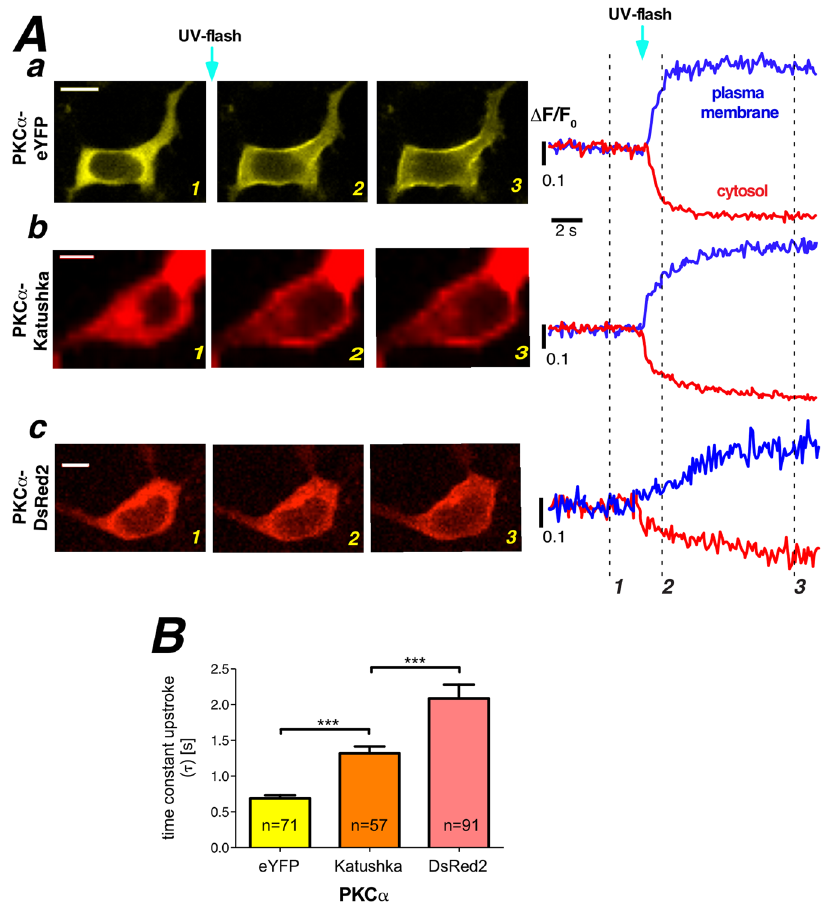
Figure 2. Properties of oligomerized PKC α -fluorescent protein. ( A ) Properties of PKC α translocation to the plasma membrane following UV flash photolysis for (Aa) PKC α -eYFP (monomeric fluorescent protein), (Ab) PKC α -Katushka (dimeric fluorescent protein), and (Ac) PKC α -DsRed2 (tetrameric fluorescent protein). Labeling of the images corresponds to the three different time points highlighted with the dashed lines. Scale bars indicate 10 μ m. ( B ) Translocation processes were quantified by fitting a mono-exponential function to the plasma membrane association traces. Statistical summary for PKC α -eYFP, PKC α -Katushka, and PKC α - DsRed2. Numbers given on the bars indicate number of cells in at least 5 independent experiments. Scale bars indicate 10 μ